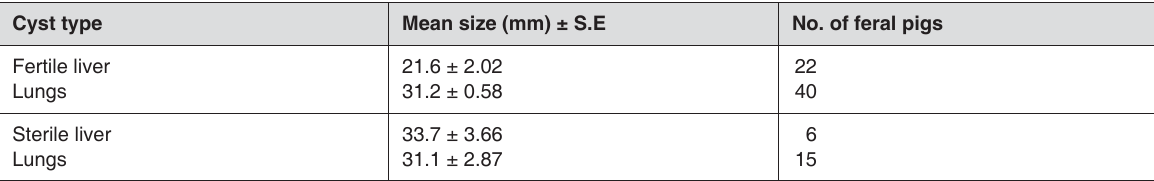
TABLE 4 Differences in the mean size (± standard error) of fertile liver and lung hydatid cysts in feral pigs Cyst